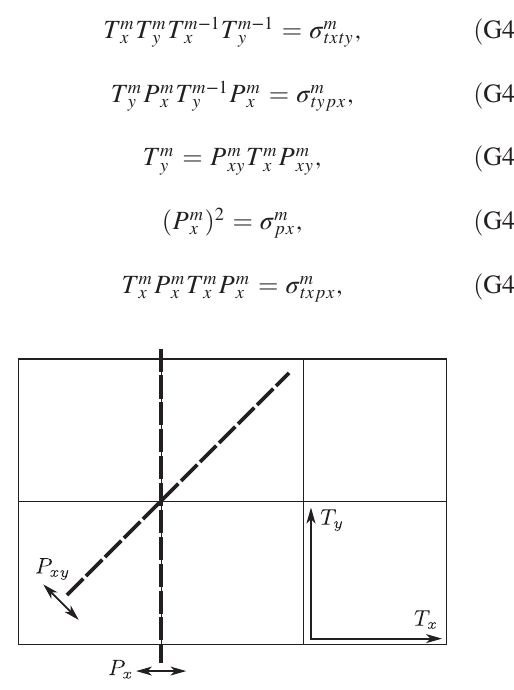
FIG. 4. Illustration of the operations generating the d ¼ 2 space group p 4 mm , the symmetry group of the square lattice. T are translations by one lattice constant along the x and y axes, respectively. The vertical dashed line is the axis for the reflection P , and the diagonal dashed line is the axis for the reflection P x